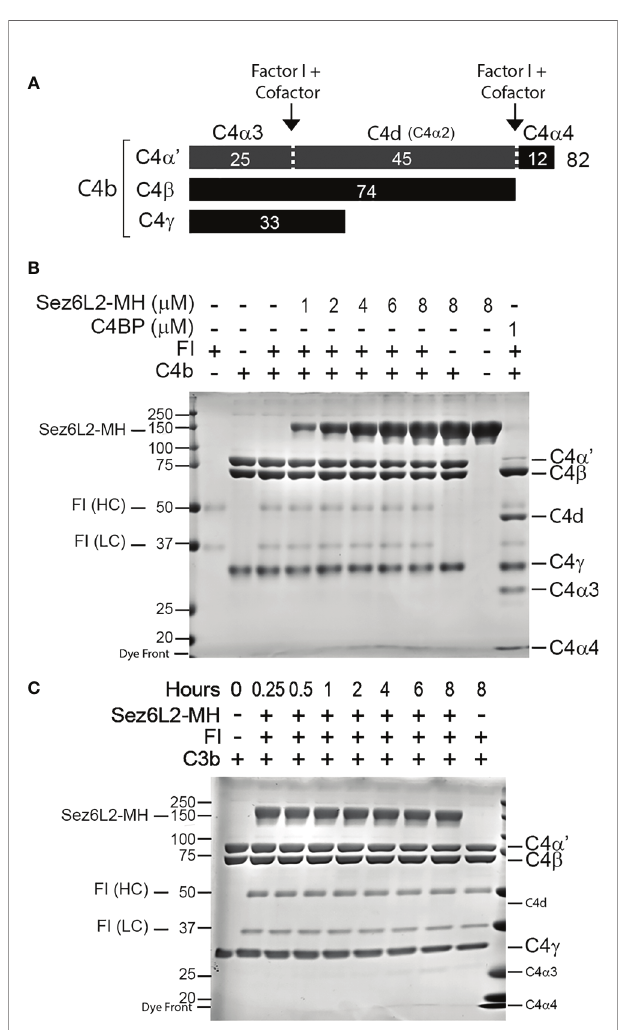
FIGURE 6 | Truncated Sez6L2 does not act as a cofactor for Factor I cleavage of C4b. (A) Schematic of Factor I plus cofactor cleavage of C4b. (B) C4b and FI were incubated alone, with concentrations of Sez6L2-MH ranging from 1 to 8 µM, or with 1 µM C4BP for two hours at 37°C. Then samples were then run and visualized on Coomassie stained gels. Incubation of C4b and FI with Sez6L2-MH did not result in the appearance of C4b cleavage products C4d, C4 a 3, or C4 a 4. On the other hand, C4BP (a known cofactor of FI for C4b cleavage) supported FI ’ s production of C4d, C4 a 3, and C4 a 4. (C) Sez6L2-MH does not support Factor I cleavage of C4b even with increased time. C4b and FI were incubated with 1.5 µM Sez6L2-MH for